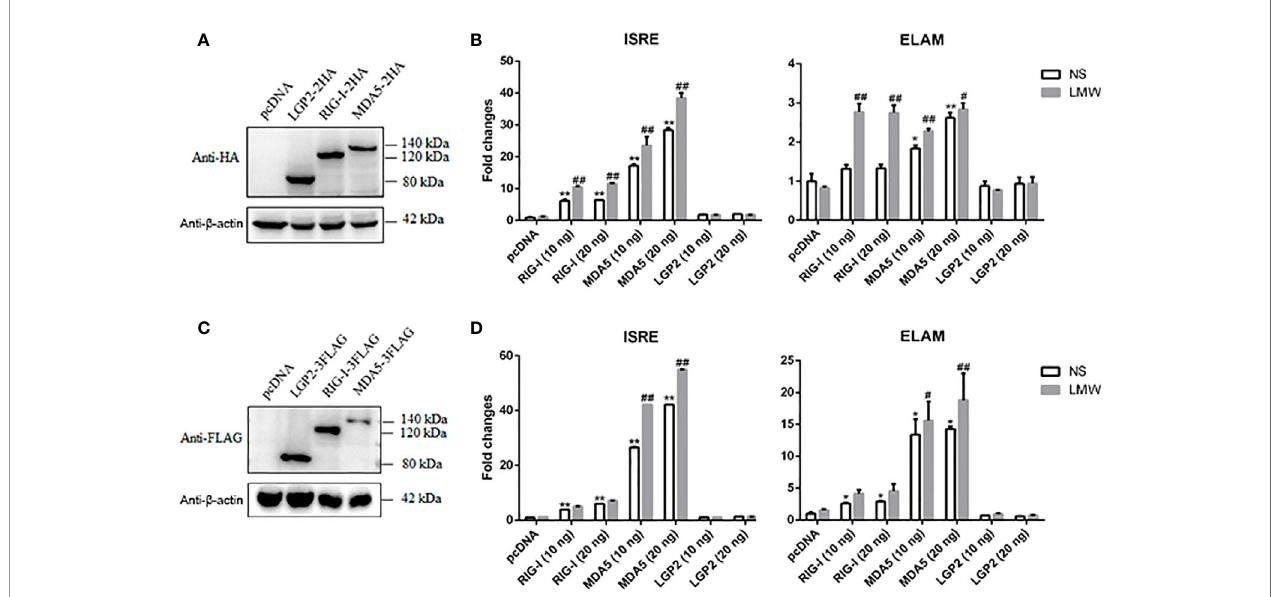
FIGURE 1 | The expression of porcine LGP2, RIG-I, MDA5 and their activity in promoter assays. (A) The pcDNA-pLGP2-HA, pcDNA-pRIG-I-HA, pcDNA-pMDA5- HA and vector pcDNA (0.5 m g each) were transfected into 293T cells in 24-well plate (3×10 5 cells/well) for 24 h using Lipofectamine 2000. The cells samples were detected by Western-blotting with anti-HA mAb. (B) 293T cells grown in 96-well plates (1×10 4 cells/well) were transfected with 10 ng or 20 ng pcDNA-pLGP2-HA, pcDNA-pRIG-I-HA, pcDNA-pMDA5-HA, plus ISRE-Fluc/ELAM-Fluc (10 ng) and Rluc (0.2 ng), which were normalized to 50 ng/well by vector pcDNA. Twenty-four hours post transfection, the cells were transfected or not with LMW poly I:C (1 m g/ml) for 8 h. The luciferase activities were measured with Double-Luciferase Reporter Assay. (C) The pcDNA-pLGP2-FLAG, pcDNA-pRIG-I-FLAG, pcDNA-pMDA5-FLAG and pcDNA were transfected as in (A) and detected with anti-FLAG mAb. (D) Promoter activation by pcDNA-pLGP2-FLAG, pcDNA-pRIG-I-FLAG, pcDNA-pMDA5-FLAG were detected as in (B) . * p < 0.05, ** p < 0.01 vs pcDNA controls. # p < 0.05, ## p < 0.01 vs non-stimulated (NS)